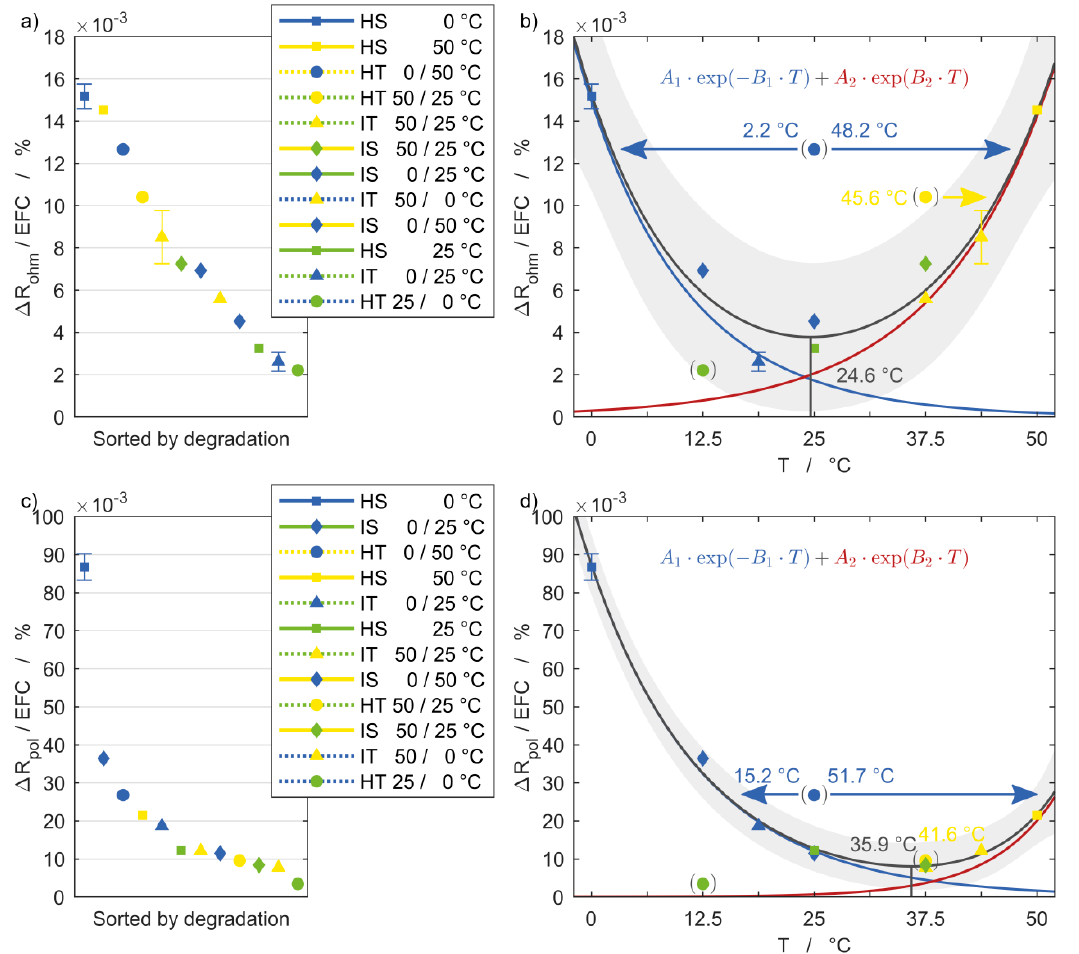
Figure 8. Electrochemical impedance degradation of ( a , b ) the ohmic and ( c , d ) the polarization resistance with reference to equivalent full cycles and in relation to the corresponding equivalent aging temperature of each setup including 95% confidence intervals.